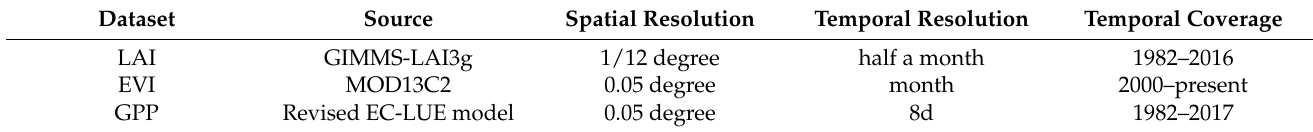
Table 1. Detailed information of the original data representing vegetation indicators in this study.